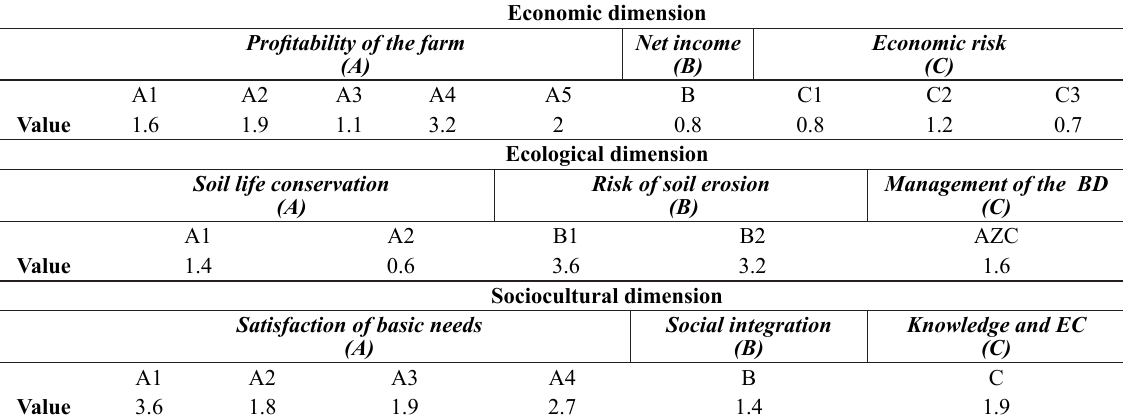
Table 3.- Scores obtained in each of the sub-indicators in the evaluation of the sustainability of lemon producing farms, in Santa Elena,